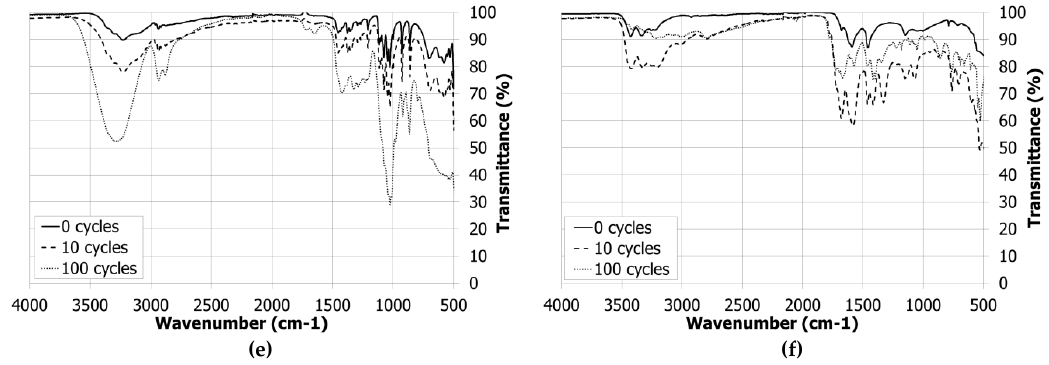
Figure 3. FT-IR spectroscopy results: ( a ) Adipic acid; ( b ) Benzanilide; ( c ) HDPE; ( d ) Dimethyl terephthalate; ( e ) Dulcitol; ( f ) Urea.